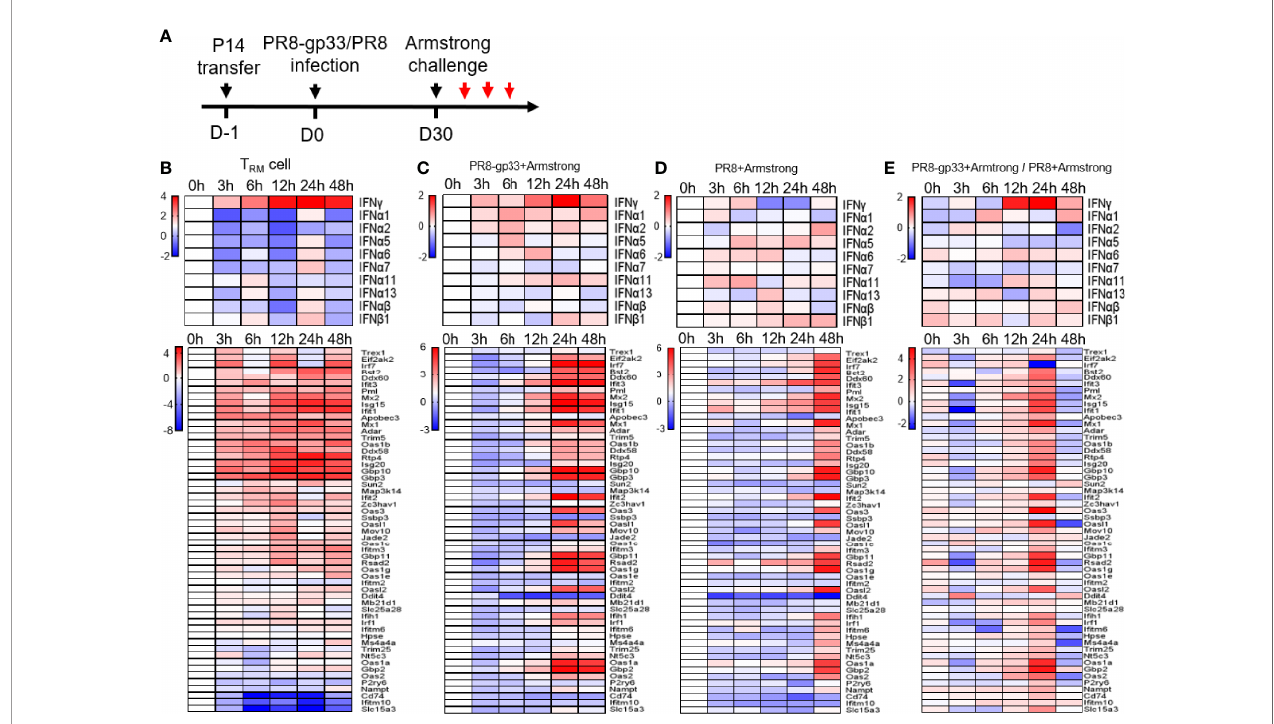
FIGURE 3 | Activated lung T RM cells rapidly upregulate IFN- g , associated with induction of ISG expression inside themselves and in the lung. Shown in (A) is the experimental scheme. Naïve mice received P14 cells by adoptive transfer and were then infected with a sublethal dose of PR8-gp33 virus or control PR8 virus, 30 days later challenged with LCMV Armstrong. The lung and BAL fl uid were harvested from animals at 0 h, 3 h, 6 h, 12 h, 24 h, and 48 h after the challenge. P14 cells were isolated from the BAL fl uid through fl ow cytometry. Microarray analyses were performed on RNAs pooled from three lungs or P14 cells isolated from three BAL samples. The revealed dynamic expression pattern of different IFNs and downstream ISGs were respectively shown as the upper and lower panel for lung CD8+ T RM cells (B) and lungs from the two treatment groups (C, D) . Shown in (E) is the heatmap constructed by the ratio of mRNA values obtained in (C, D)